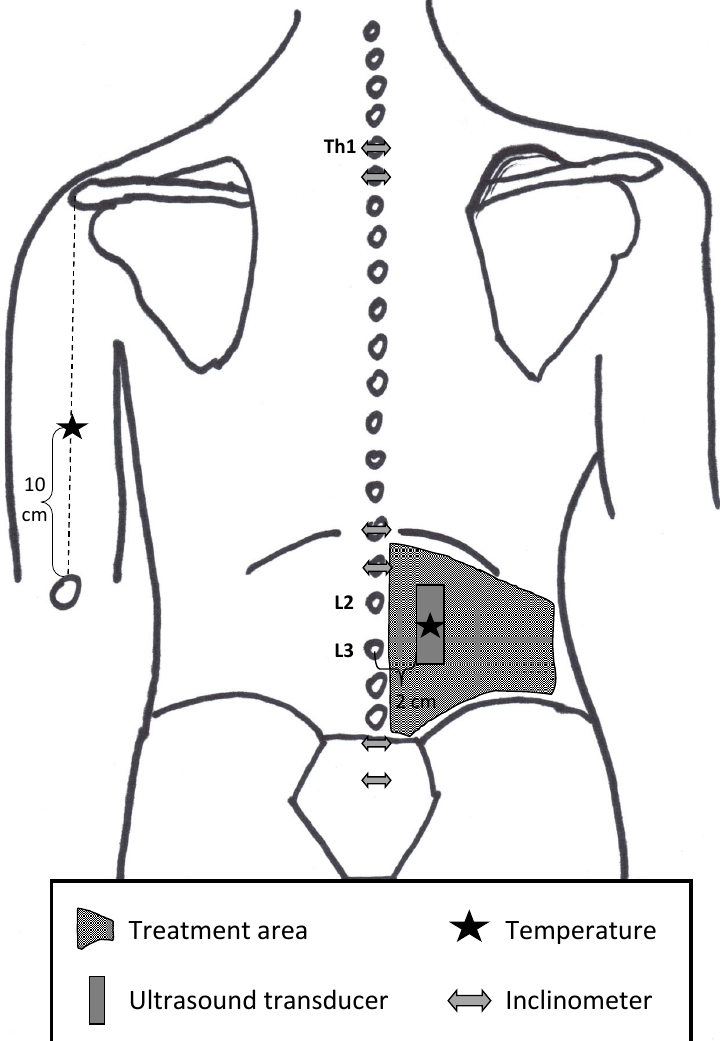
Figure 2. Body chart for schematic representation of the measurement points, shown on the treatment side. Th: thoracic vertebra; L: lumbar vertebra. Adapted from the original by Weber et al. (2020) [37].